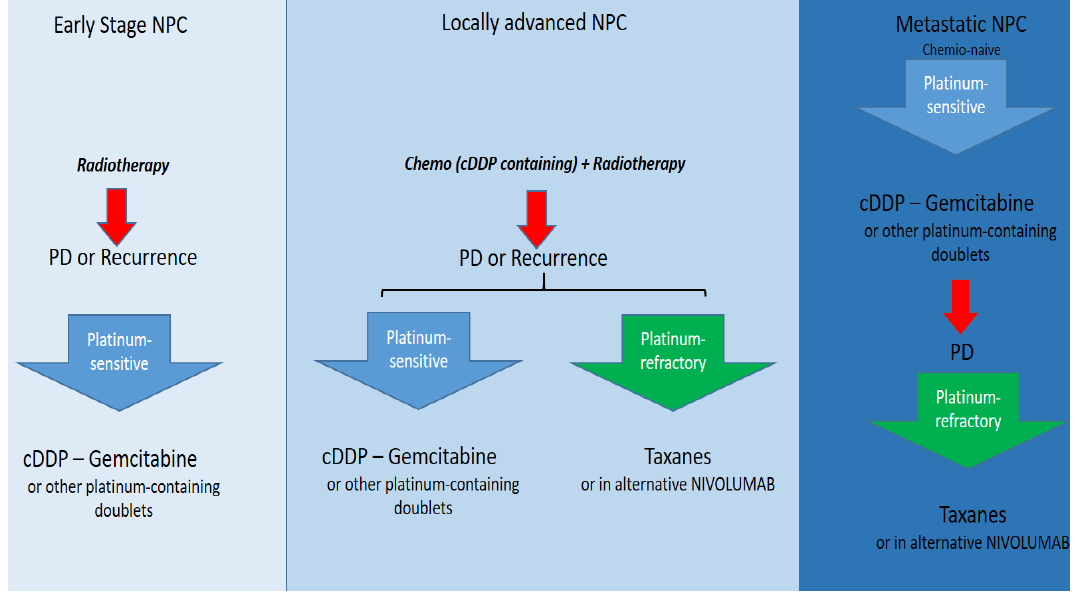
Figure 4. Current therapy options in NPC overall.